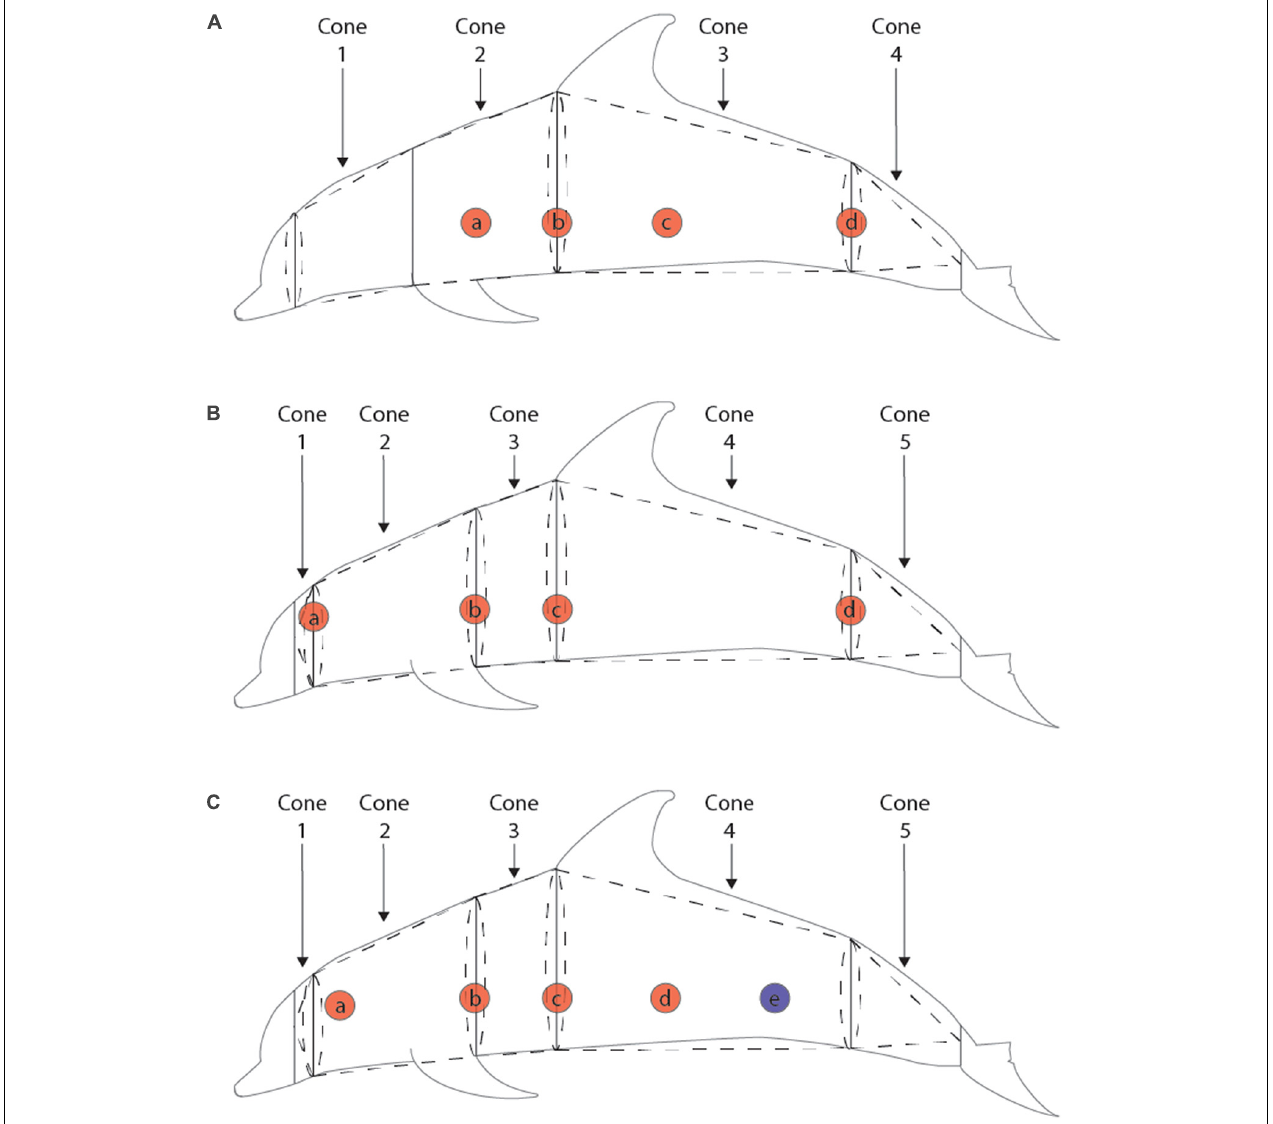
FIGURE 1 | Girth, blubber depth, and truncated cones methods for three time periods: pre-1989 (A) , 1989–2012 (B) , and post-2012 (C) . Solid lines indicate placement of girth measurements, red circles indicate lateral placement of ultrasound measurements of blubber depth, blue circles indicate approximate location of caudal biopsy of blubber depth, and dotted lines represent the breakdown of cones used in the truncated cones calculations. For the pre-1989 measurements, the average of blubber depths a and b were averaged for cones 1 and 2, the average of blubber depths b and c were used for cone 3, and blubber depth d was used for cone 4. For the 1989–2012 measurements, blubber depth a was used for cone 1, the average of blubber depths a and b were used for cone 2, the average of blubber depths b and c were used for cone 3, the average of blubber depths c and d were used for cone 4, and blubber depth d was used for cone 5. For the post-2012 measurements blubber depth a was used for cone 1, the average of blubber depths a, b, and c were used for cones 2 and 3, and the average of blubber depths c, d, and e were used for cones 4 and